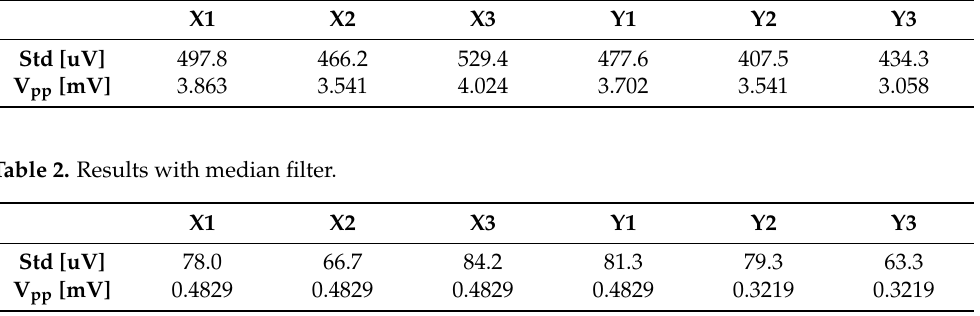
Table 1. Results without median filter.